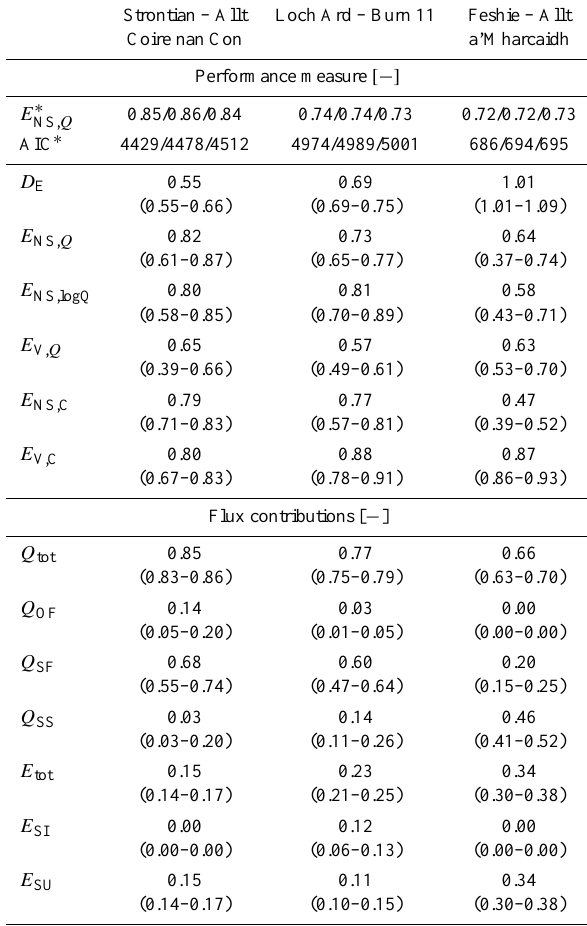
Table 4. Model performance measures for the performance metrics used in model calibration. The first values represent the respective performance measures for the model with the lowest D E , i.e. the “most balanced model”, the values in the brackets indicate the per- formance range of the 5-D pareto front. The lower part of the table gives flux contributions of individual model components from the “most balanced” parameterization and those with the members of the 5-D calibration pareto fronts (in